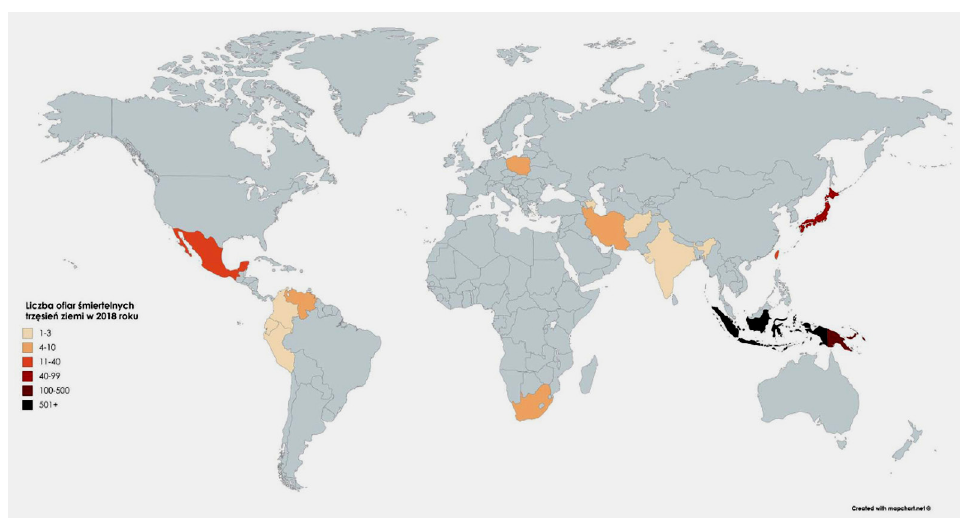
Fig. 3. Map posted in the analysed group showing the number of deaths in earthquakes in 2018. A correct colour scale along with presentation of total values in spatial units (a diagram map would be a better solution here) (reproduced with the permission of its